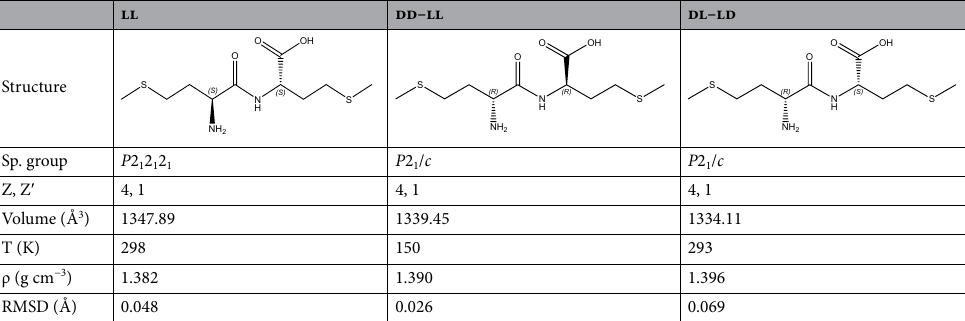
Table 2. A comparison of some key parameters for the three crystal structures of methionyl-methionine. RMSD = root mean square deviation for a 15 molecule overlay of the experimental and optimized (DFT-D, variable cell) crystal structures in Mercury.